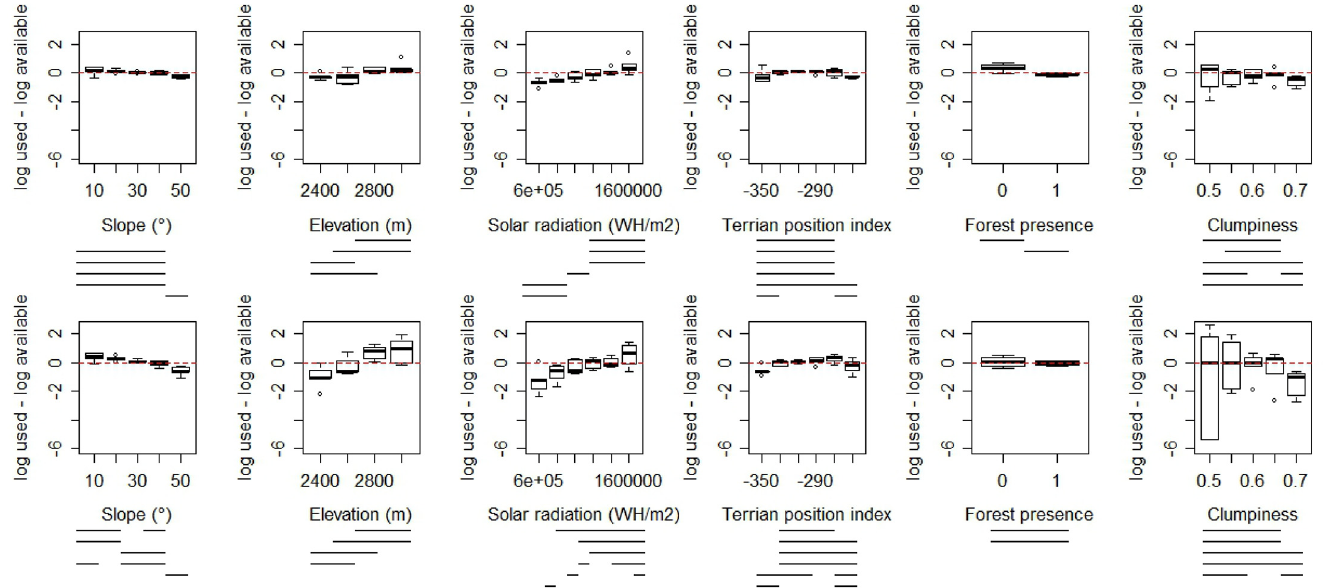
Fig 6. Habitat selection by GPS-collared giant pandas for various biogeophysical characteristics at two selection levels- the within-home range level (top row) and the at-home range level (bottom row). Habitat use of each class was calculated as the proportion of the utilization distribution. Habitat availability was calculated as the proportion of habitat available within individual home ranges (top row) and within the entire study area (bottom row). Lines below each plot represent significant differences in selection across levels determined via randomization tests.